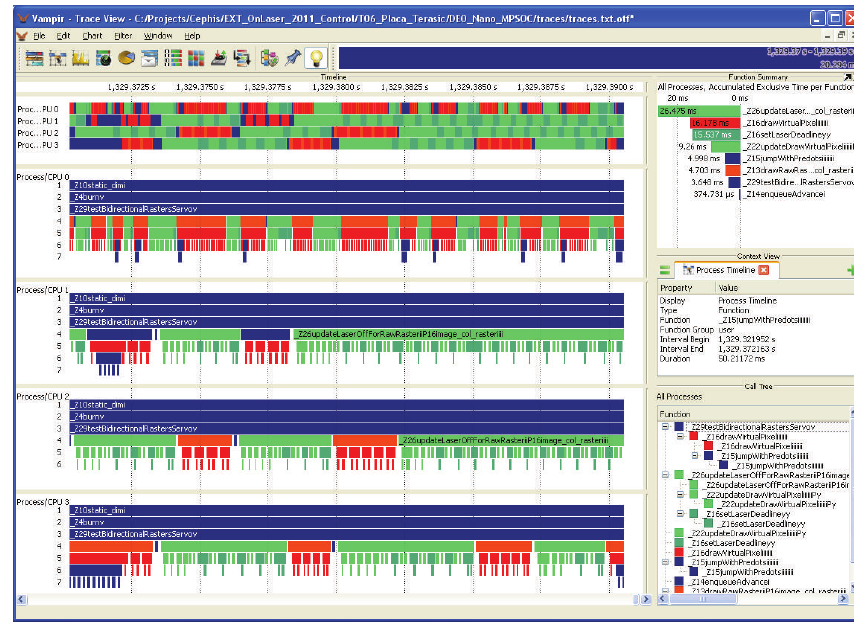
Figure 10: Trace-based analysis using Vampir of a compiler-based generated trace.